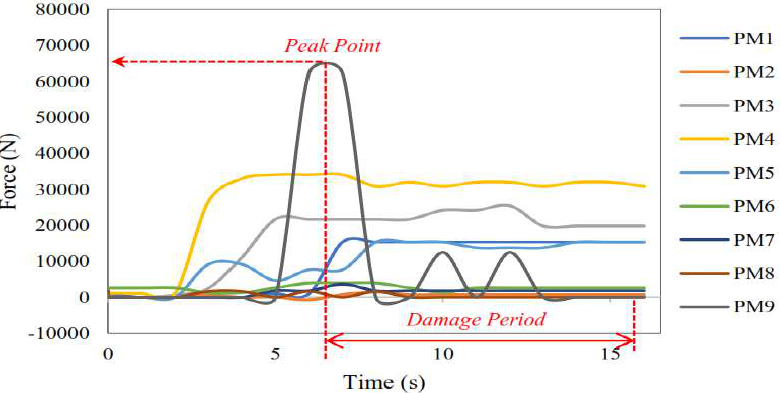
Figure 20. Graph of 3 m reservoir water level test 3 for model 2.